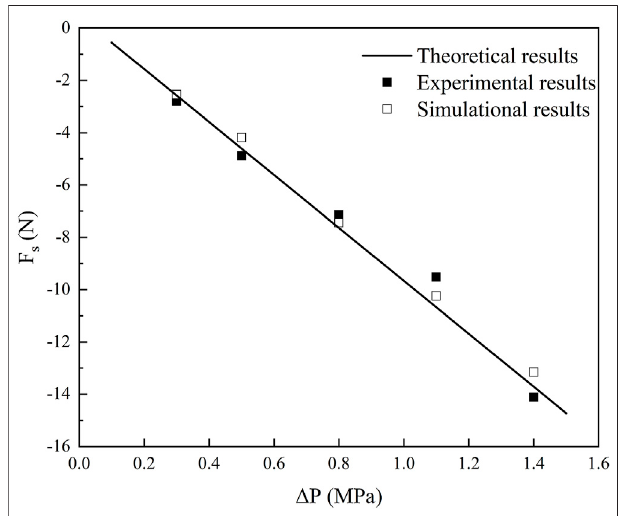
FIGURE 9 | The local pressure distribution along the outline of the valve core tip under various differential pressure conditions.